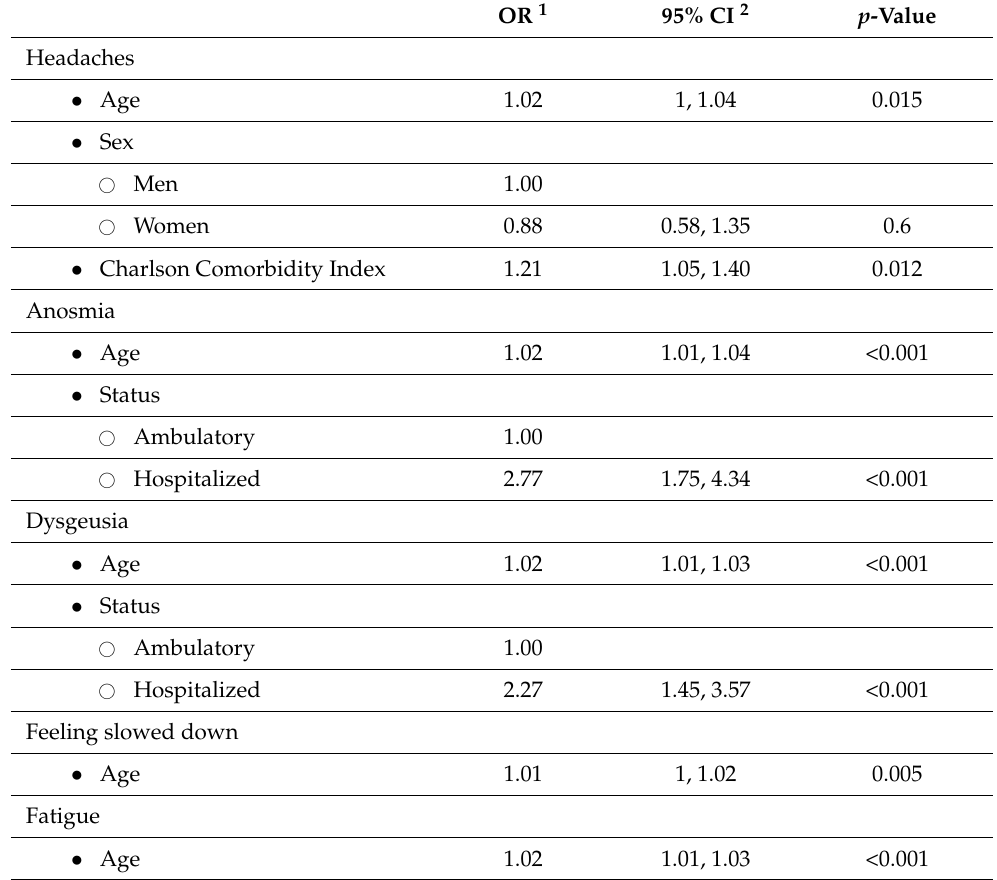
Table 5. Factors associated with the absence of improvement at 1 year by multivariate